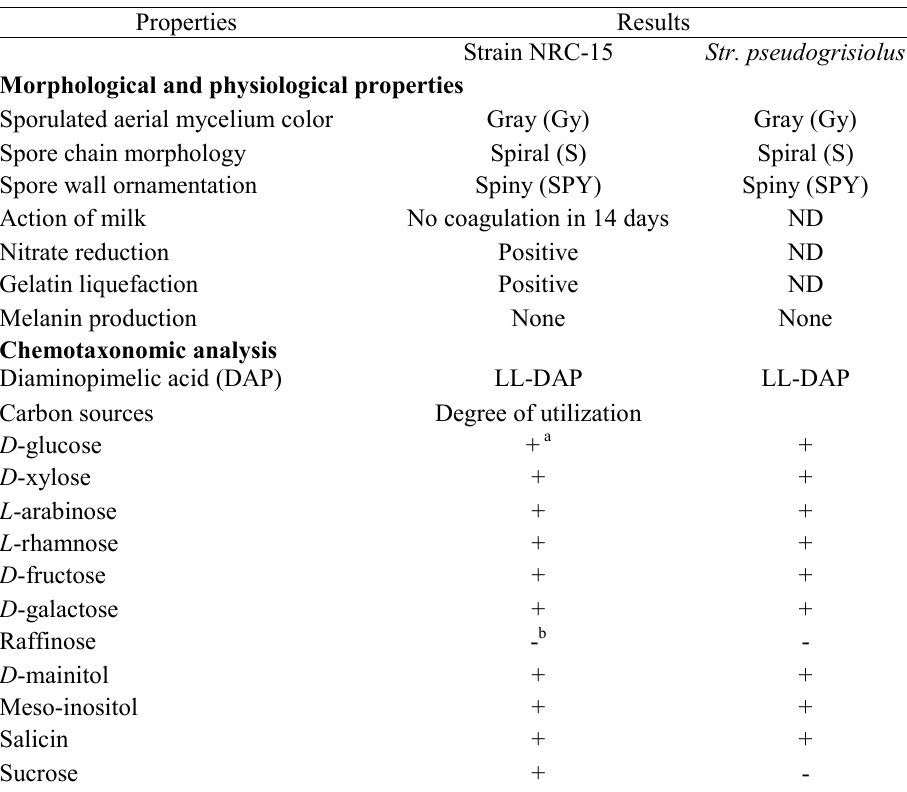
Table2. Identification of strain NRC-15 by physiological and biochemical tests comparing with Str.